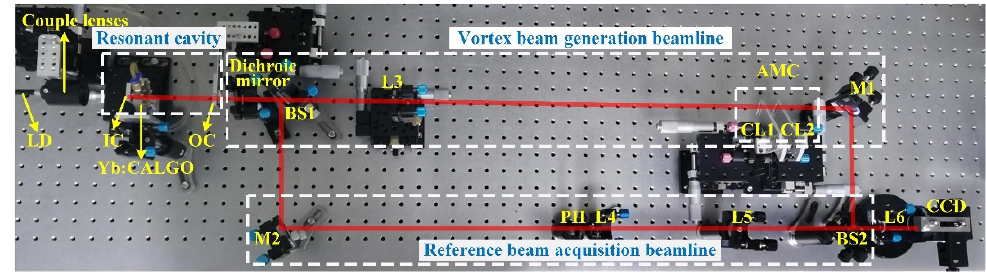
Figure 13. Experiment setup of the mode-tunable vortex beam.